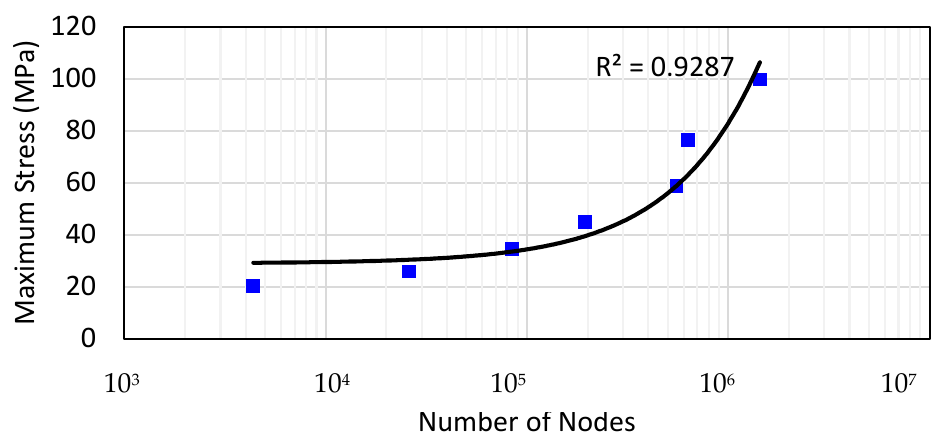
Figure 16. Plots of attempted mesh divergence for BCC UC using local stress as the driving parameter. In comparison to the algorithm for meshing ORG UC structure, a clear independent mesh value of roughly 2.715 µ m at 1M nodes is shown in Figure 17. A logarithmic conver- gence for nodes and maximum deformation can be seen, indicating that the mesh is reliable.